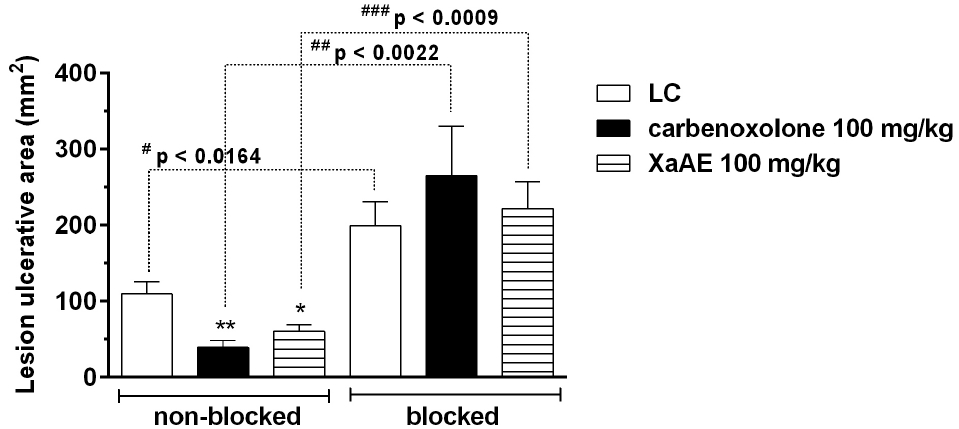
Figure 10. Gastroprotective effect of the X. americana aqueous extract (XaAE) stem bark on absolute ethanol-induced (99%, 1 mL, orally) gastric lesions in Wistar rats before (non-blocked, NaCl 0.9%, 10 mL/kg, i.p.) and after (blocked) treatment with L-NAME (70 mg/kg, i.p). The animals received 0.9% NaCl solution orally (lesioned control, LC, 10 mL/kg), carbenoxolone (orally) or XaAE (orally). Results were expressed as mean ± SEM (6–7 animals/group). Statistically different when compared to the lesioned control group (ANOVA, followed by Dunnett’s multiple comparisons test, * p ˂ 0.05, ** p < 0.005). # The non-blocked and blocked control groups were compared by an unpaired Student’s t -test, ## The non-blocked and blocked carbenoxolone 100 mg/kg groups were compared by an unpaired Student’s t -test. ### The non-blocked and blocked XaAE 100 mg/kg groups were compared by an unpaired Student’s t -test.